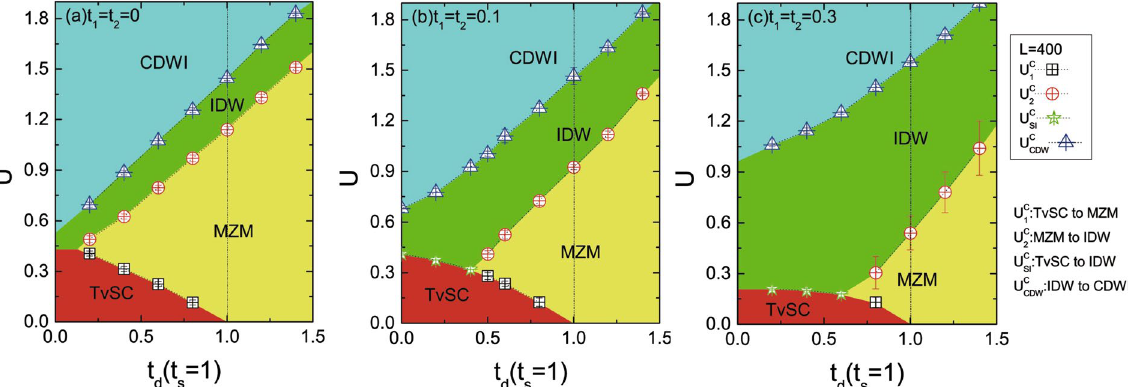
Figure 2. Phase diagram for various t 1,2 values. The t d vs U phase diagram of the interacting Majorana ladder at ( a ) t 1,2 = 0 ( b ) t 1,2 = 0.1 t s and ( c ) t 1,2 = 0.3 t s . The dot line locates the noninteracting topological phase boundary t d = t s . TvSC, MZM, IDW and CDWI separately represent the trivial superconducting states, Majorana zero modes, incommensurate charge-density-wave liquids and commensurate charge-density-wave insulators. Phase boundaries between TvSC and MZM, MZM and IDW, TvSC and IDW, and IDW and CDWI, are described by black squares (corresponding to critical interaction U c ( U c ), respectively. CDW